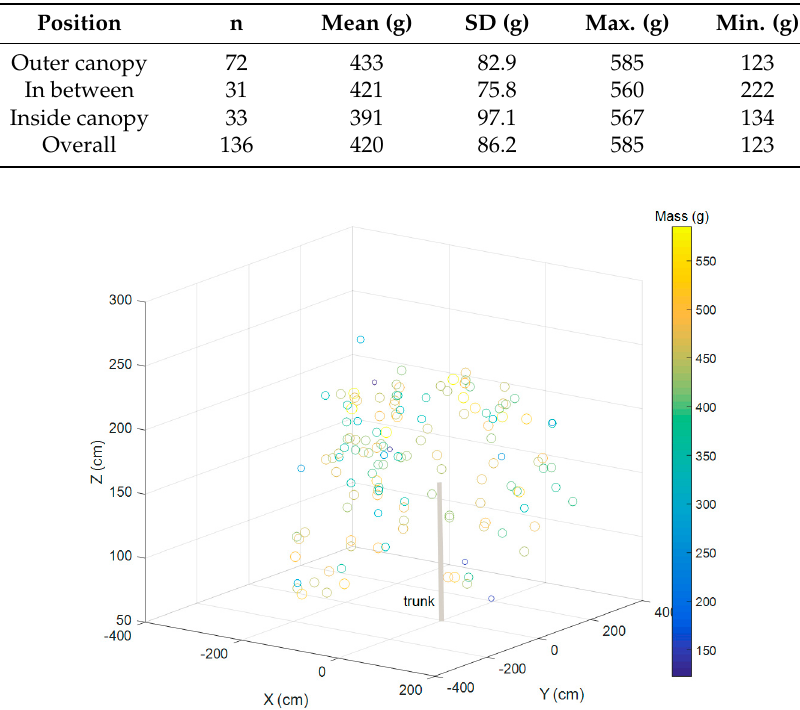
Figure 6. Representation of fruit position within a tree canopy, colored and sized by fruit mass. The X axis is perpendicular to the orchard row, the Y axis is parallel to the orchard row, and the Z axis is tree height. The co-ordinate (0, 0, 0) represents the center of the trunk at ground level. The scale bar represents fruit mass (150 to 550 g).